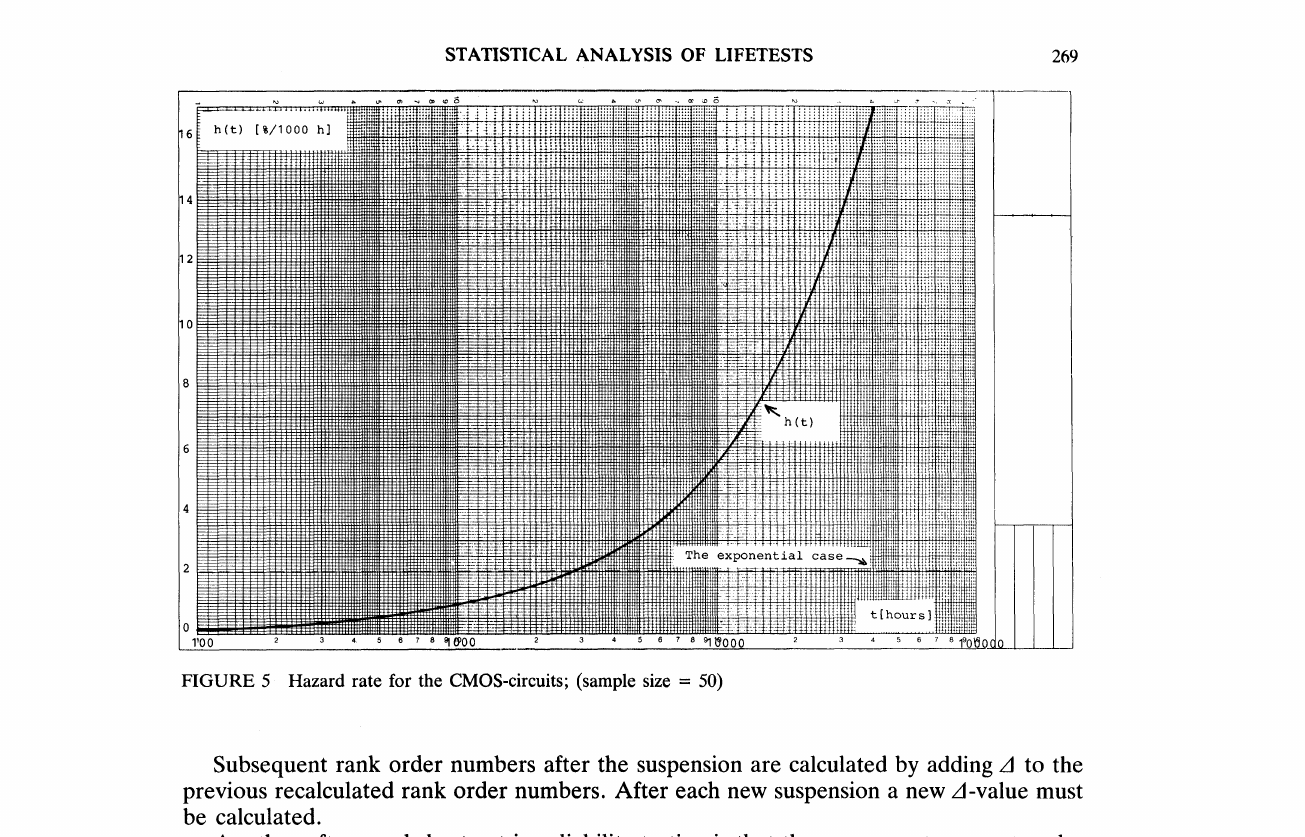
FIGURE 5 Hazard rate for the CMOS-circuits; (sample size